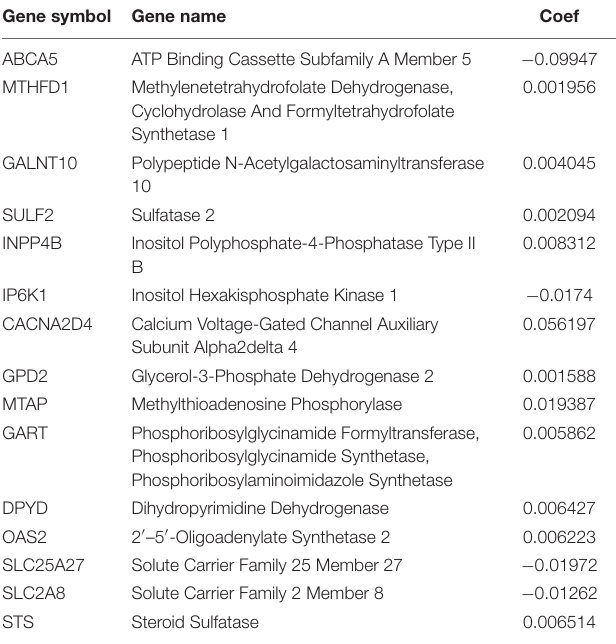
TABLE 1 | Model gene list and